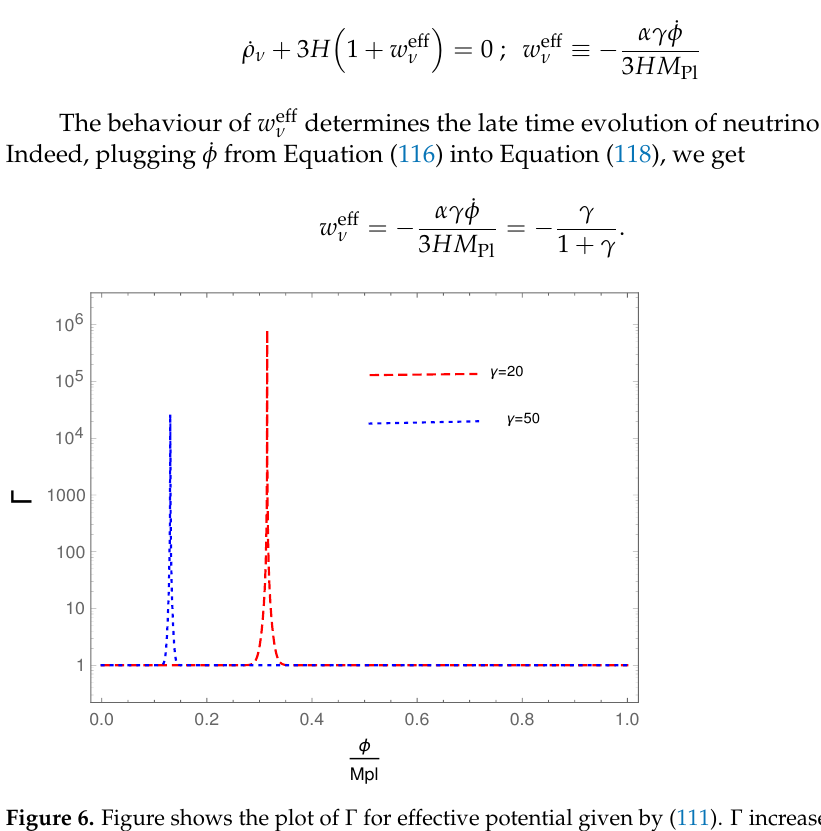
Figure 6. Figure shows the plot of Γ for effective potential given by (111). Γ increases rapidly during slow roll, which happens here around the minimum, which shifts towards larger values of φ for smaller values of γ . The plot is for α = 10 and the potential is normalised by V 0